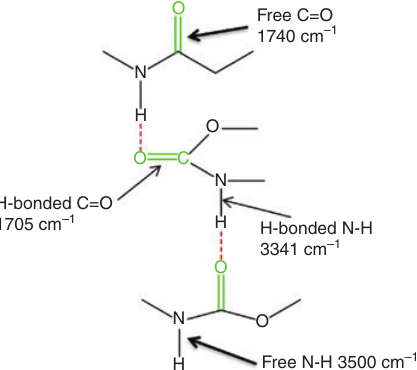
Figure 5: Showing probable H-bonding evolved in polyurethane (PU)-prepolymer reaction with assigning their IR bands.